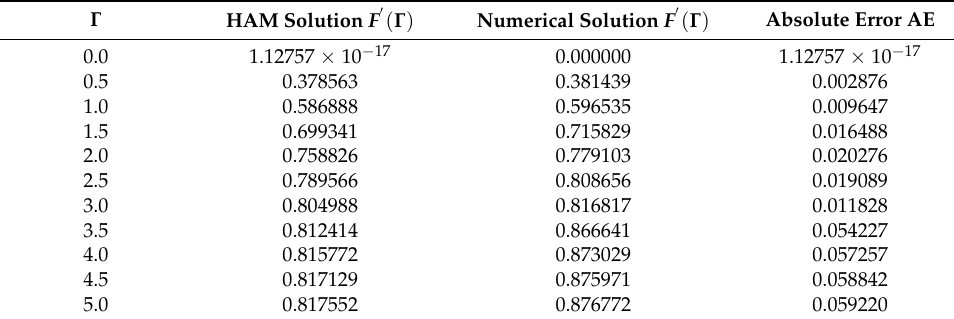
Table 3. The association between HAM and numerical solution for F (cid:48) ( Γ ) , when K = 0, A = 0.2, κ =